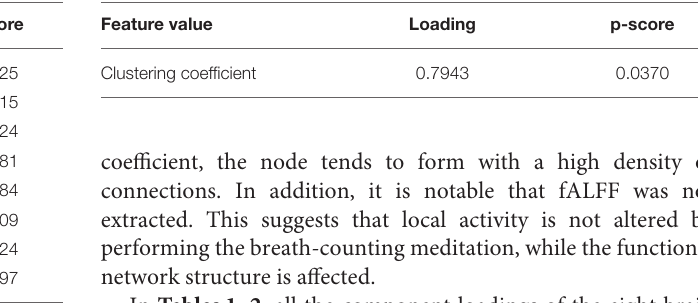
TABLE 1 | First component loading of brain regions ( p < 0.05). TABLE 2 | First component loading of feature values ( p <